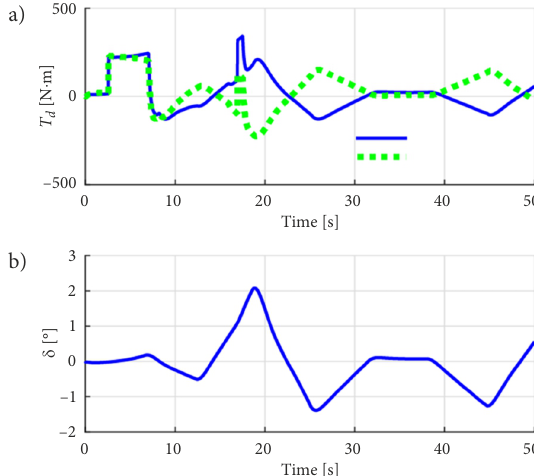
Figure 17. Control inputs (source: created by the authors): a – drive torque; b – steering